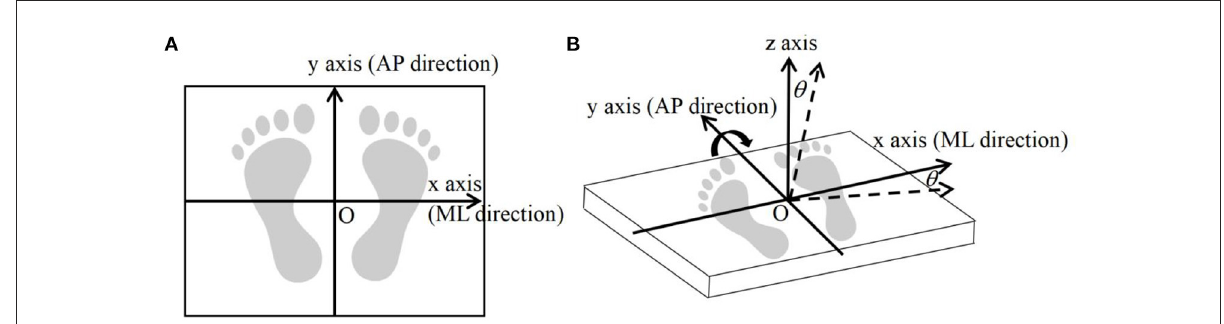
FIGURE1 Schematic diagram of the dynamic force platform. (A) The patient stands still and upright on the stationary force platform with bare feet, with the y- axis in the AP direction and the x- axis in the ML direction. (B) The patient stands upright and barefoot on the dynamic force platform. The platform swings periodically around the y- axis. The patient needs to maintain body balance during the swinging process. The z- axis is the vertical direction when the patient stands. θ is the instantaneous swing angle of the platform. ML, medial-lateral; AP, anterior-posterior.